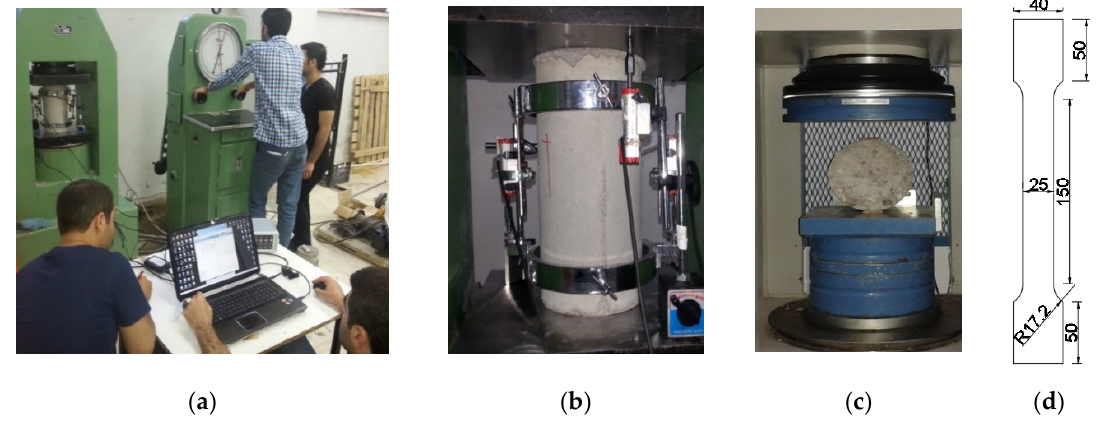
Figure 7. Compression test, ( a ) general view of the setup ( b ) measuring devices ( c ) splitting test setup ( d ) coupon specimen used in tensile test of steel plate.